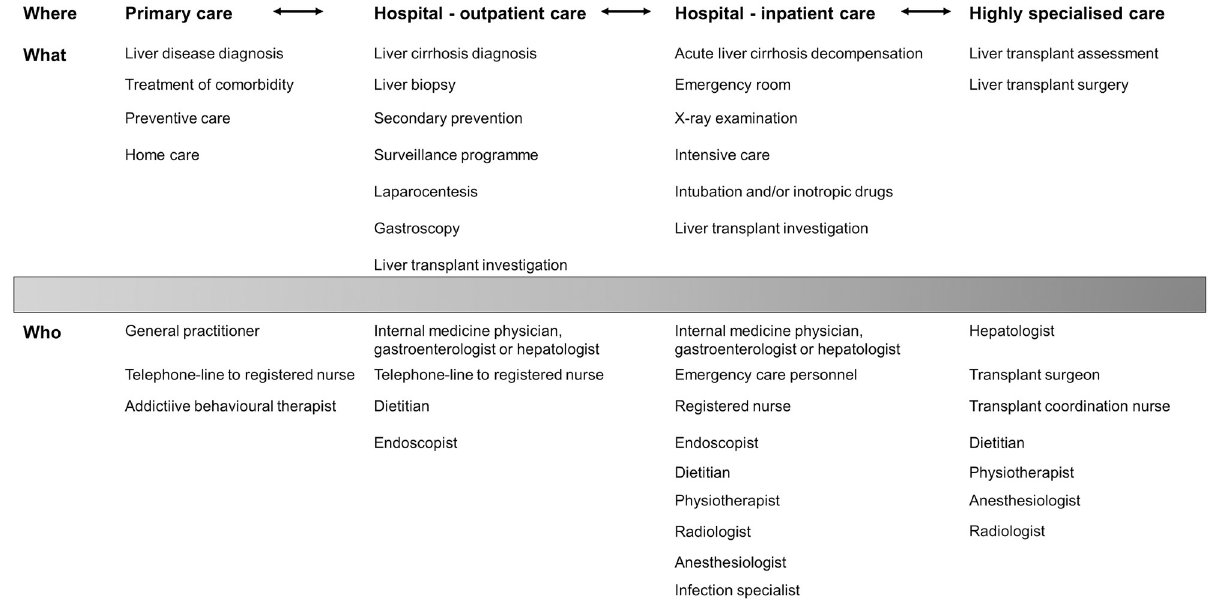
Fig 1. The continuum of cirrhosis care in